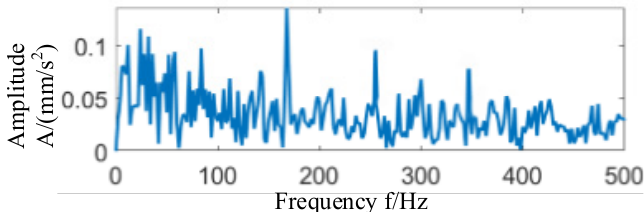
Figure 28. Envelope spectra of the transient shock characteristics.